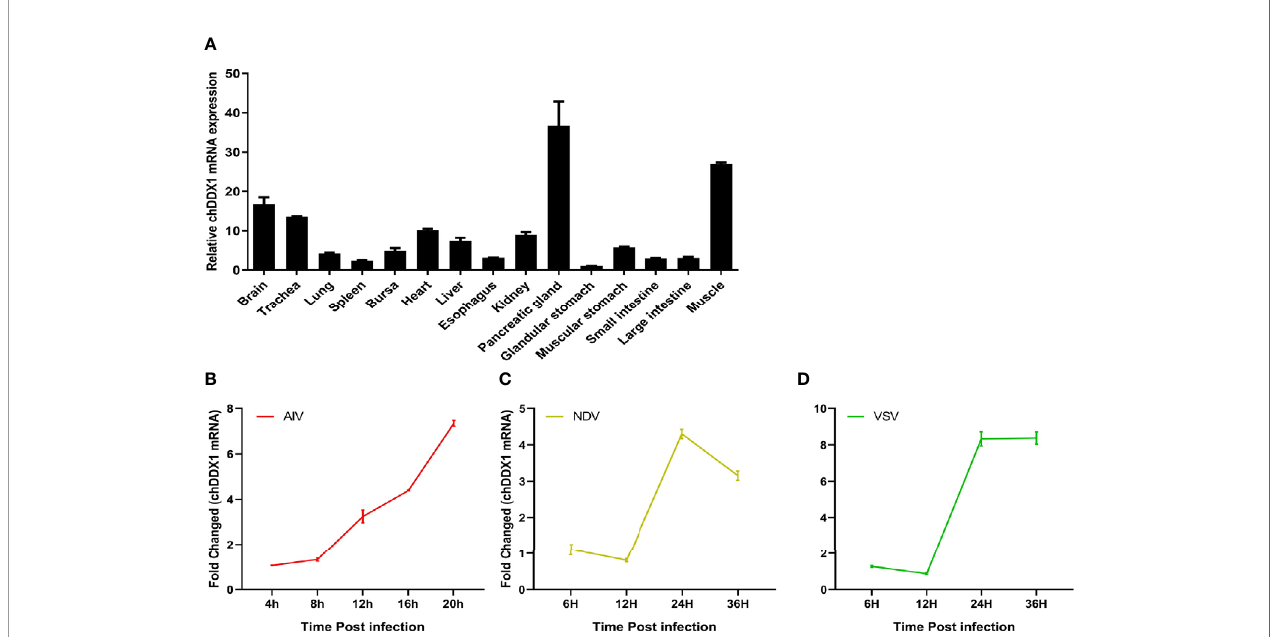
FIGURE 3 | (A) Tissue distribution of chDDX1 mRNA in SPF chicken tissues. chDDX1 mRNA levels are expressed as relative mRNA indexes, calculated as the index (the copy number of chDDX1 mRNA/the copy number of b -actin mRNA) of the test tissue divided by the index of muscle. (B) Upregulation of chicken DDX1 in DF-1 cells infected with AIV at 0.1 MOI. (C) Upregulation of chDDX1 in DF-1 cells infected with NDV at 0.1 MOI. (D) Upregulation of chDDX1 in DF-1 cells infected with VSV-GFP at 0.1